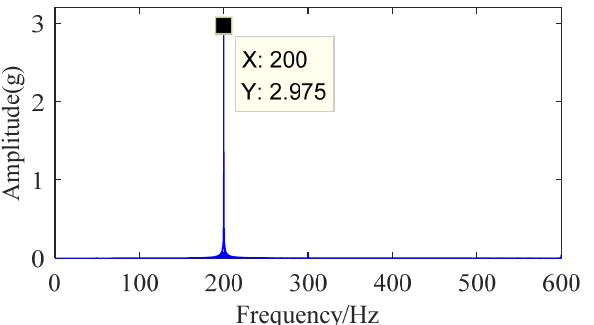
Figure 15. Vibration response of unpainted stainless steel clamp and pipeline under 200 Hz fixed- frequency excitation.